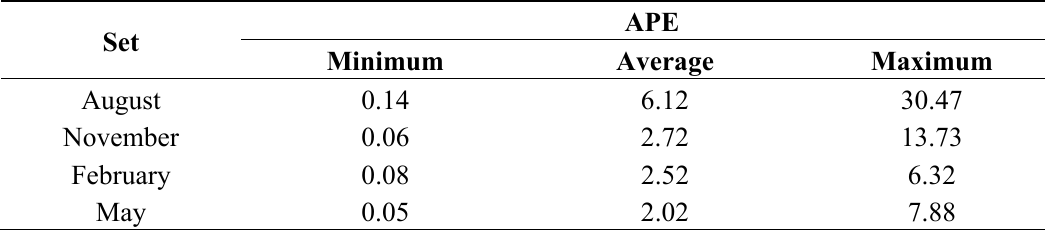
Table 1. Daily APE for next day average load